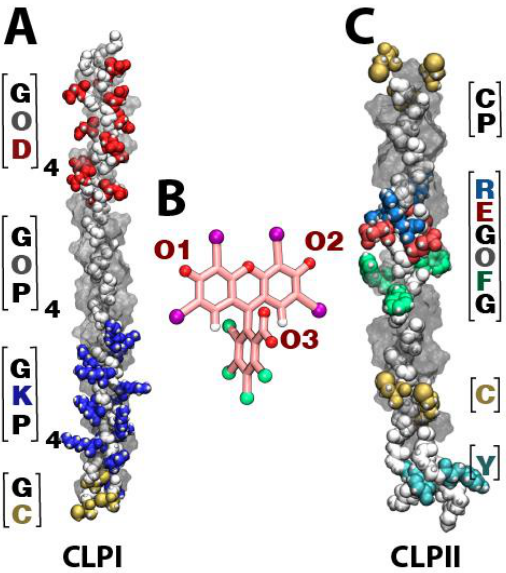
Figure 1. RB structure and structural domains on CLPI and CLPII. ( A ) Three-dimensional structure of CLPI, highlighting negative amino acids in red ([DOG domain]), positively charged amino acids in blue ([PKG] domain) and cysteines in yellow. ( B ) Molecular three-dimensional model of RB. The RB backbone was colored pink; atoms of oxygen, nitrogen, chlorine, and iodide were colored red, blue, green, and purple, respectively. ( C ) Three-dimensional structure of CLPII, highlighting the [GFOGER] domain and the cysteine and tyrosine resides. Figure 2. Three-dimensional organization of CLPI and CLPII driven by RB. ( A , D ) Initial structural configuration of a CLPI and CLPII system and RB, respectively. ( B , E ) Frequency of contact of RB with CLPI and CLPII, respectively. ( C , F ) Representative snapshot of the most probable final struc- tural conformation of CLPI and CLPII systems stabilized by the binding of RB.